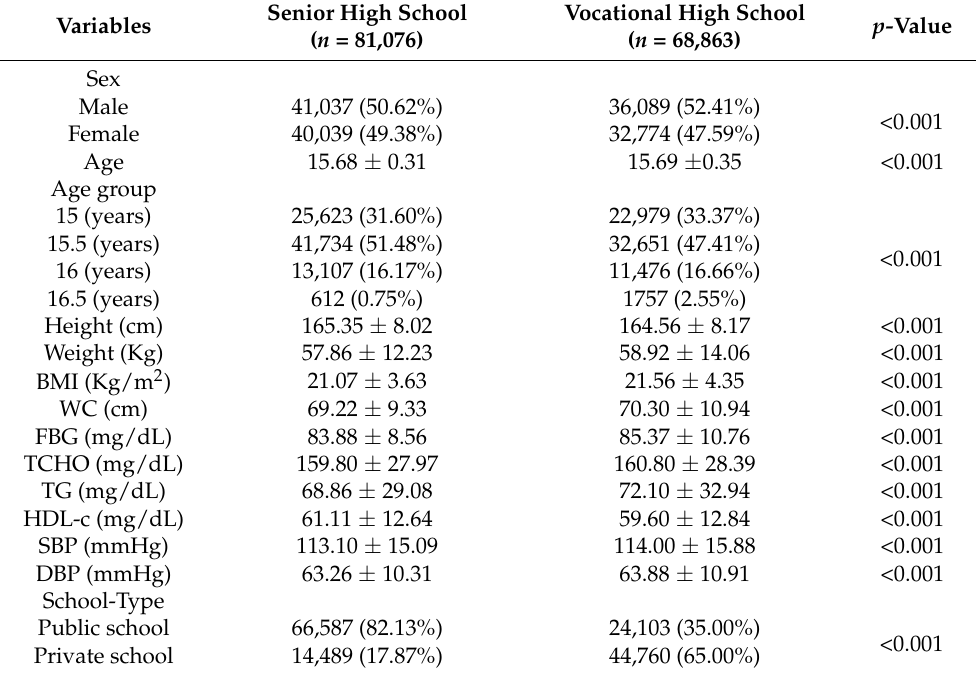
Table 2. Basic characteristics of senior and vocational high school